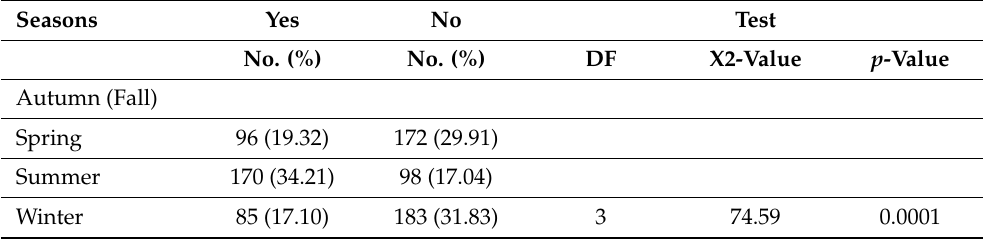
Table 4. Contingency analysis of flowering honey bee plants by seasons in Al-Baha region, south- western Saudi